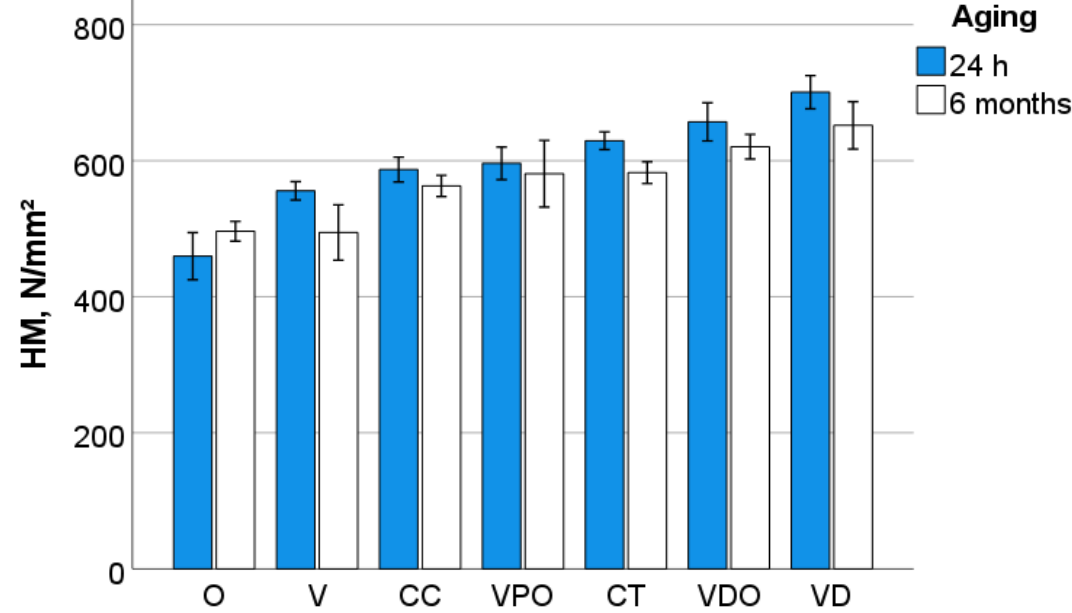
Figure 7. Variation of the Martens hardness (HM) as a function of RBC and aging conditions (mean values with 95% confidence interval).